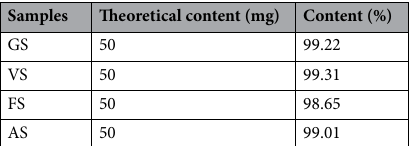
Table 5. Quantification of SLD in marketed tablets (n =